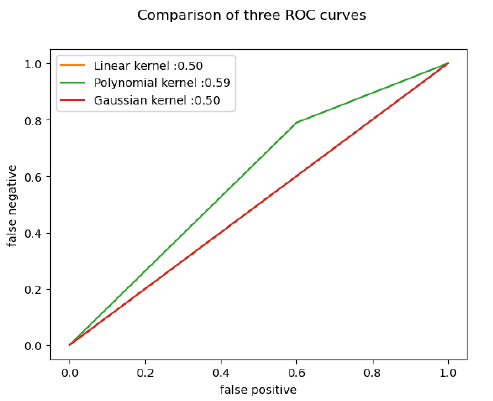
Figure 11. Offline ROC